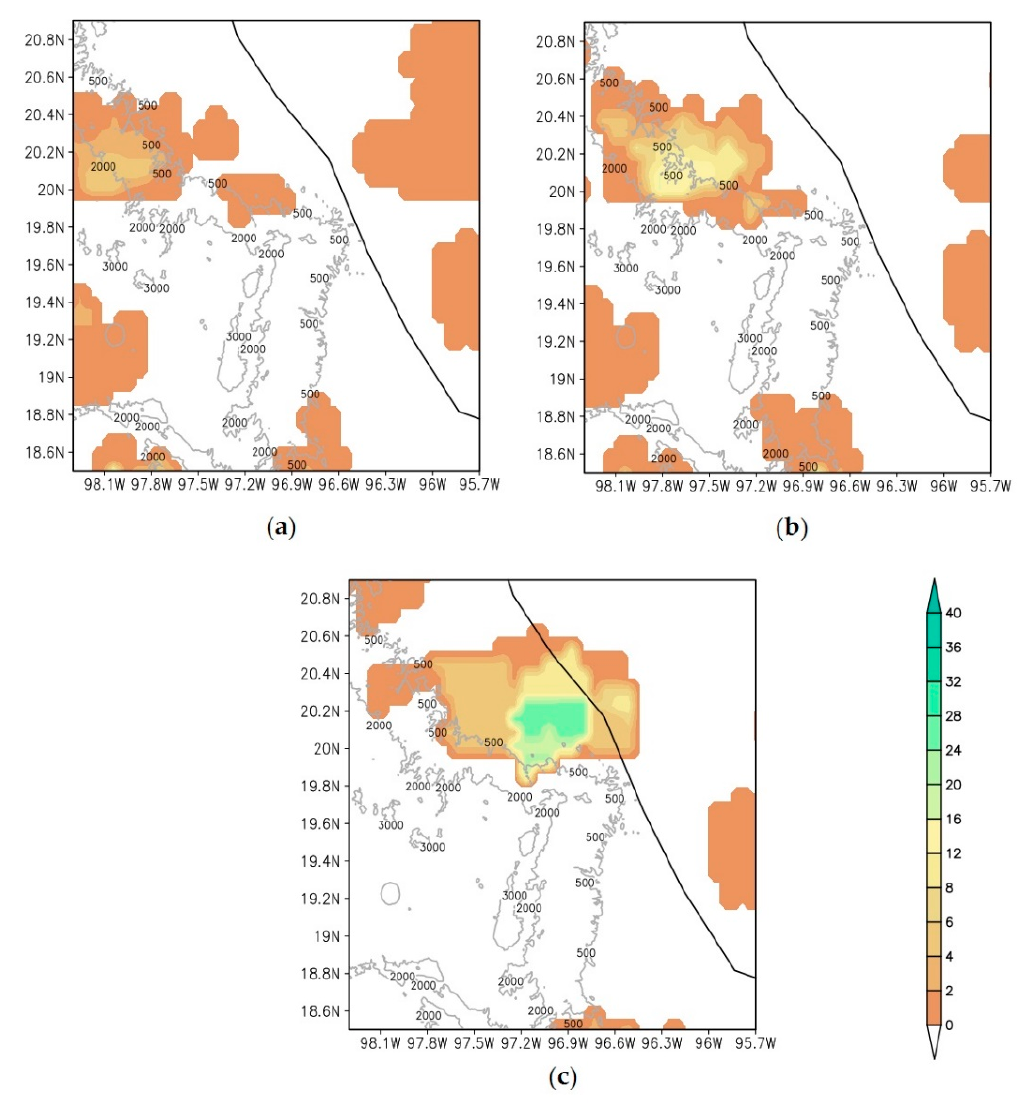
Figure 11. Rainfall (mm h − 1 ) using CMORPH data (8-km spatial resolution) at ( a ) 19 LT, ( b ) 21 LT, and ( c ) 23 LT for the day 29 June 2015. The contours of 500 and 2000 m.a.s.l. are shown. Moreover, over the northern flank of the TMVB headland (between 19.6 rainfall propagated from the foothills to the coastline between 16 and 19 LT reaching the Gulf of Mexico by late afternoon (Figure 12), indicating that the sequence of events on 29 June was not unique. Furthermore, this propagation of the rainfall is consistent with the westerly winds observed at 19 LT on 30 June over on northern flank of the TMVB headland (Figure